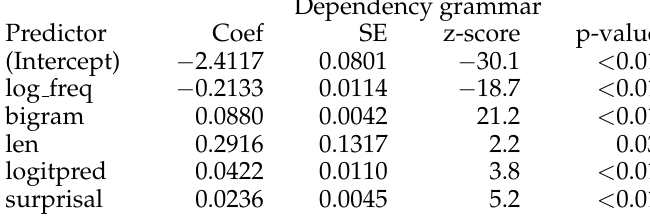
Log unigram and bigram frequencies, 1/length, and the two surprisal variants as predictors of regression probabilities. Dependency grammar Phrase-structure